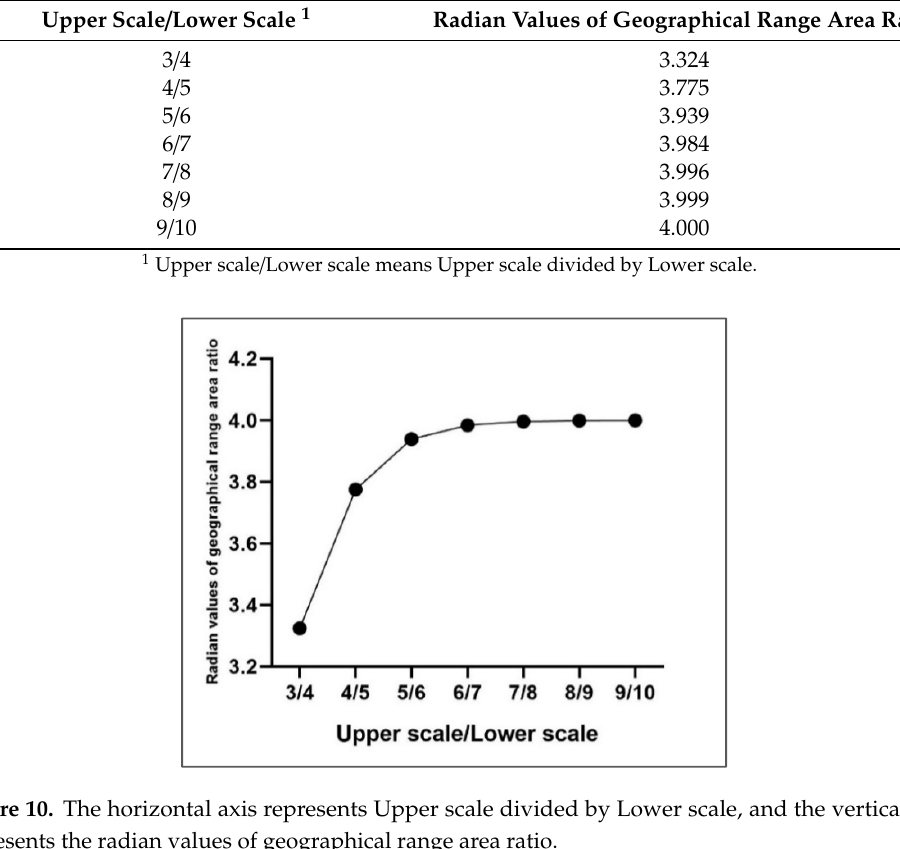
9.295 Figure 11. Line chart of map scale and value of map load. The horizontal axis represents map scale, and the vertical axis represents the value of map load. Table 4 shows the results of corresponding relationship between the value of map load and different basic sampling intervals at the map scale of 1:500,000. Table 4. Corresponding table of basic sampling interval and map load. Basic Sampling Interval